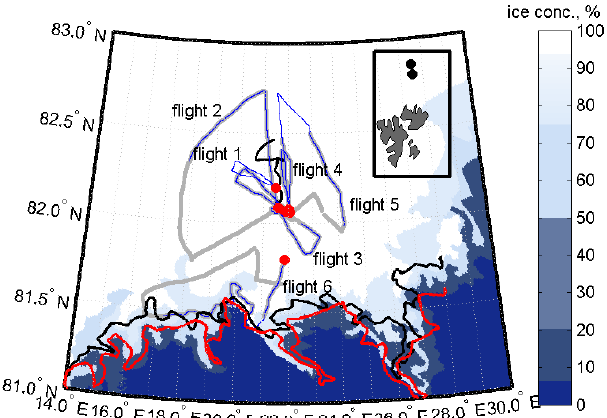
Figure 1. Map of the study area showing the track of the ICE12 floe during the drift north of Svalbard from 26 July to 3 Au- gust 2012 (solid black line); an inset map in the upper right corner also shows the start and end drift coordinates relative to the Sval- bard archipelago. The black and red curves outline the ice edge on 2 days, 31 July and 2 August, defined as 40% ice concentration based on ice charts from the Norwegian Meteorological Institute (NMI). The NMI ice chart from 1 August is shown as the refer- ence. The grey and blue lines show the segments of six helicopter ice-reconnaissance flight tracks with EM bird and ICE camera data, respectively (see Table 1). Red dots mark the starting points for the